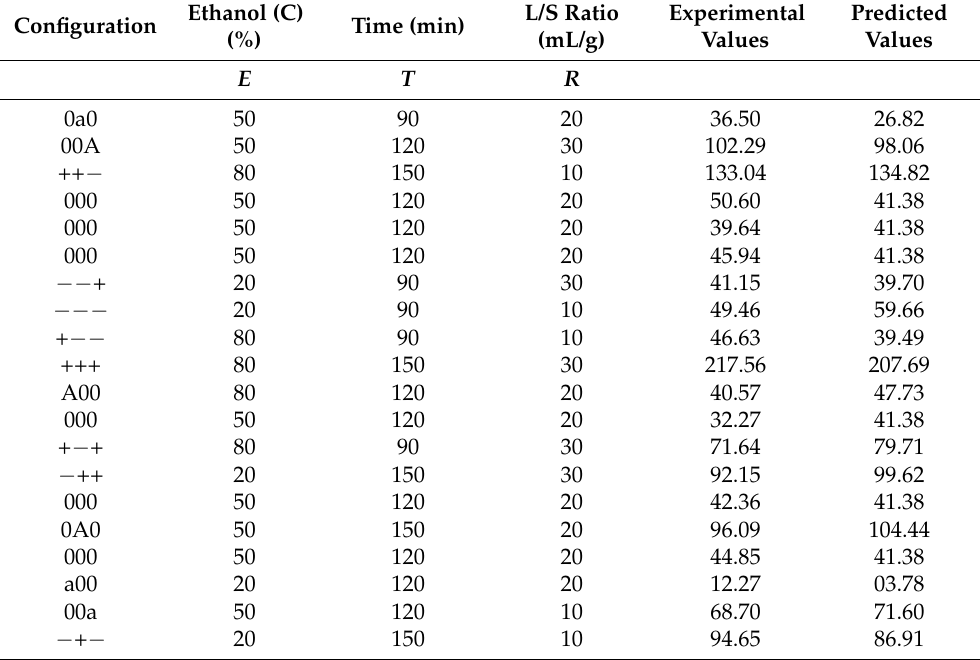
Table 2. Experimental and predicted parameters of TPC (mg/100 g DW) extraction yields from PP using central composite